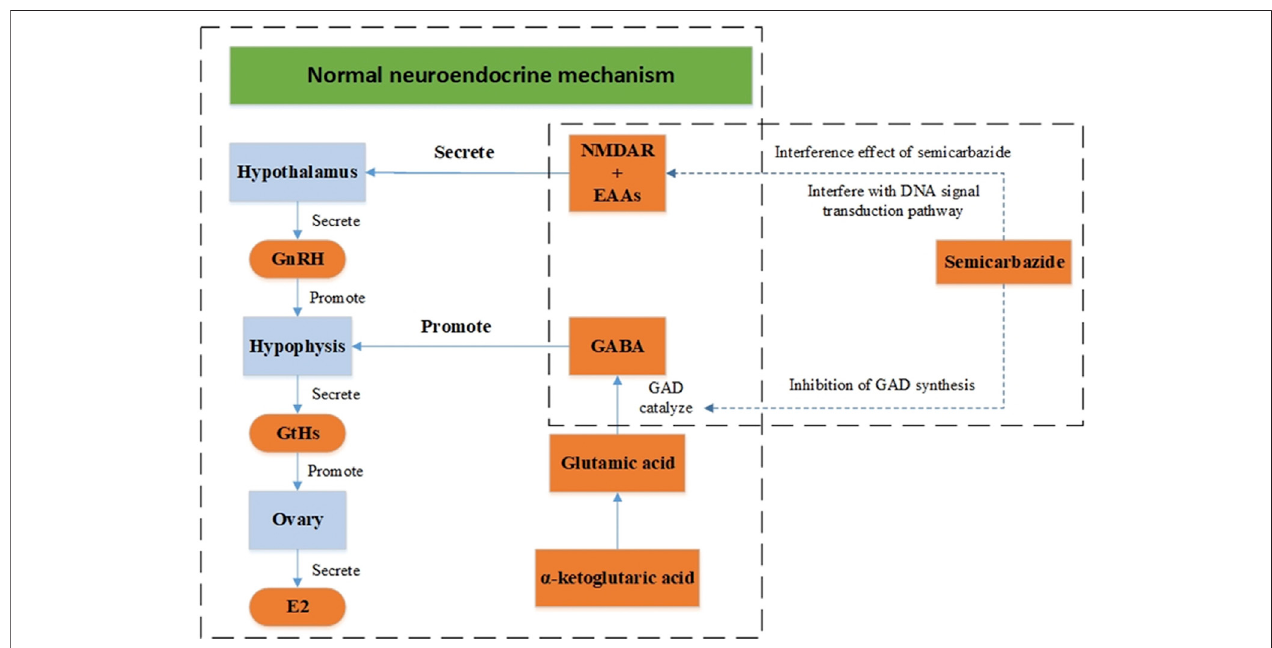
FIGURE 5 | Neuroendocrine regulation model of